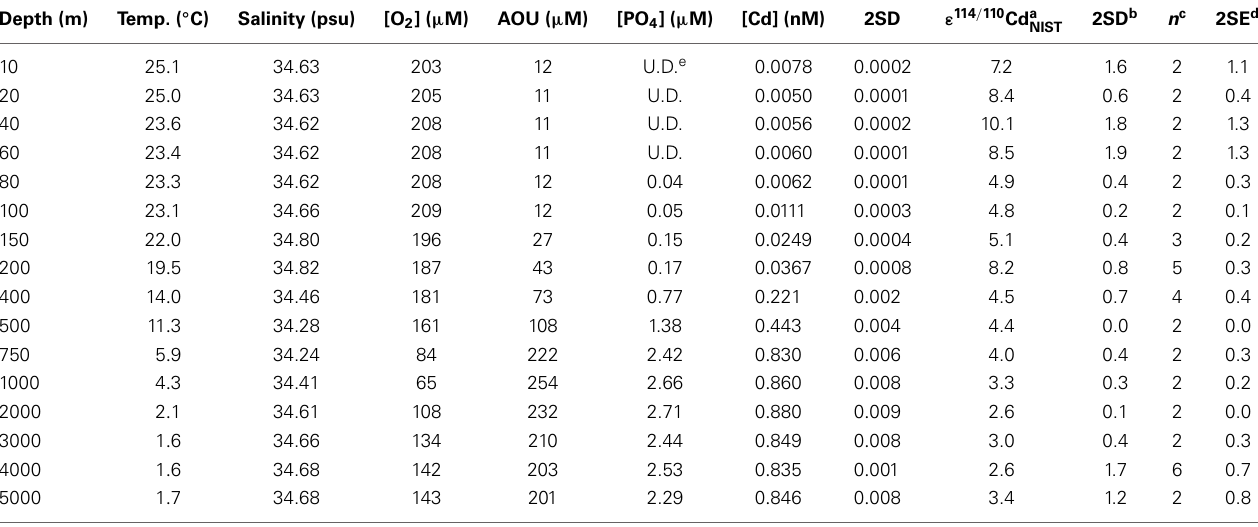
Table 1 | Cd concentrations and isotope compositions for seawater samples collected in the West Philippine Sea. Depth (m) Temp. ( ◦